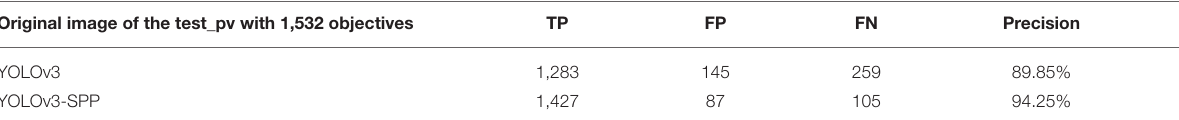
TABLE 1 | The detection results of the test_pv before and after the improvement of YOLOv3 network. Original image of the test_pv with 1,532 objectives